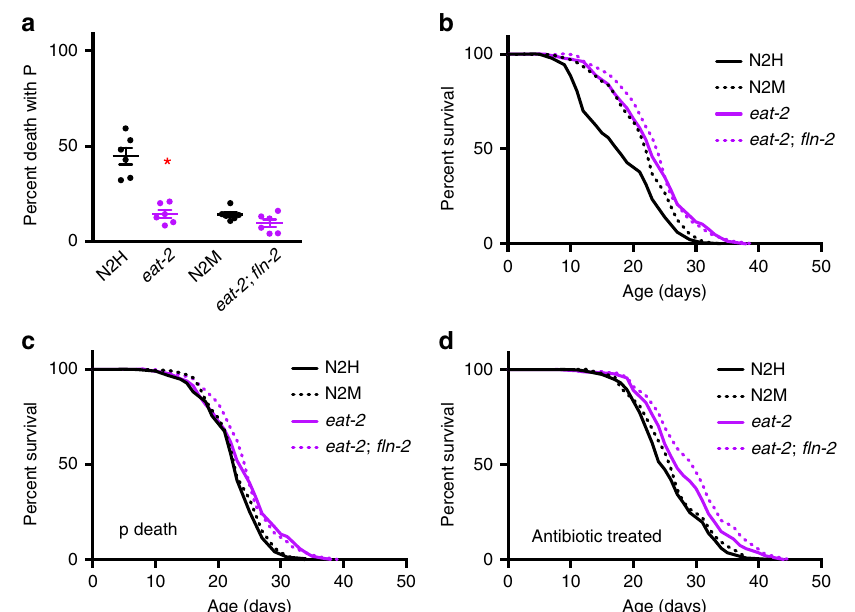
Fig. 5 Reduction of P death by fl n-2(ot611) masks lifespan effects of eat-2 . a Necropsy analysis and b lifespan of eat-2(ad1116) mutants in fl n-2( + ) or fl n-2 (ot611) backgrounds. N2H survival curve indicated by solid black line, N2M by dashed black line, eat-2 by solid purple line, and eat-2 fl n-2 by dashed purple line. Error bars represent s.e.m. of three trials. See Supplementary Table 11 for full statistics, and Supplementary data 1 for raw mortality data. Source data are provided as a Source Data fi le. c eat-2(ad1116) causes a small but signi fi cant increase in p sub-population lifespan in both fl n-2( + ) and fl n-2(ot611) backgrounds. See Supplementary data 1 for raw mortality data. d Effects of fl n-2(ot611) on lifespan in eat-2(ad1116) mutants disappears after treatment with antibiotics (200 μ g/ml carbenicillin). See Supplementary data 1 for raw mortality